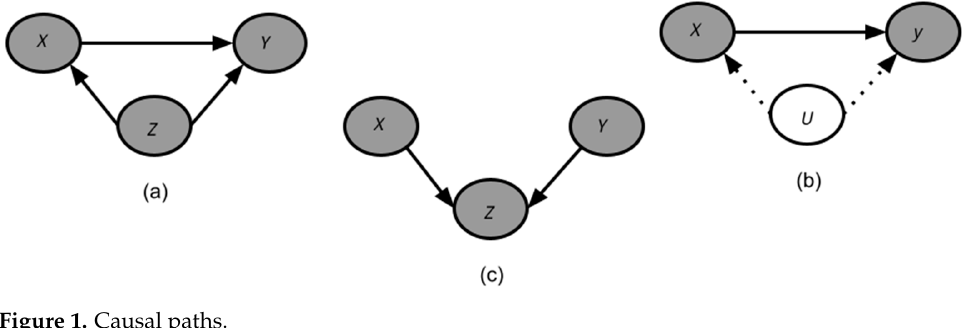
Figure 1. Causal paths.